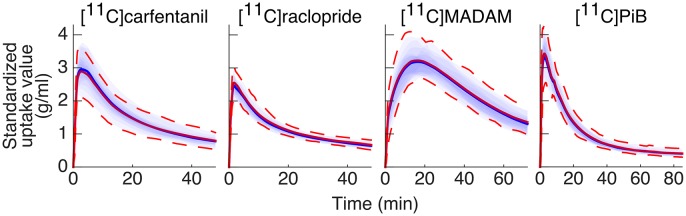
Between-subject mean time-activity curves. Blue = Magia; red = manual.